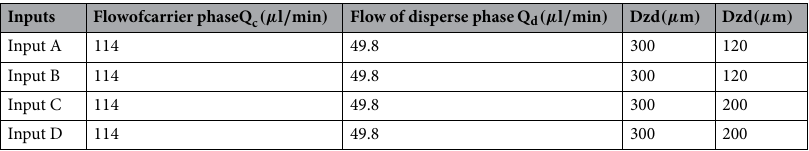
Table 1. Input parameters of the combinatorial microfluidic circuit.